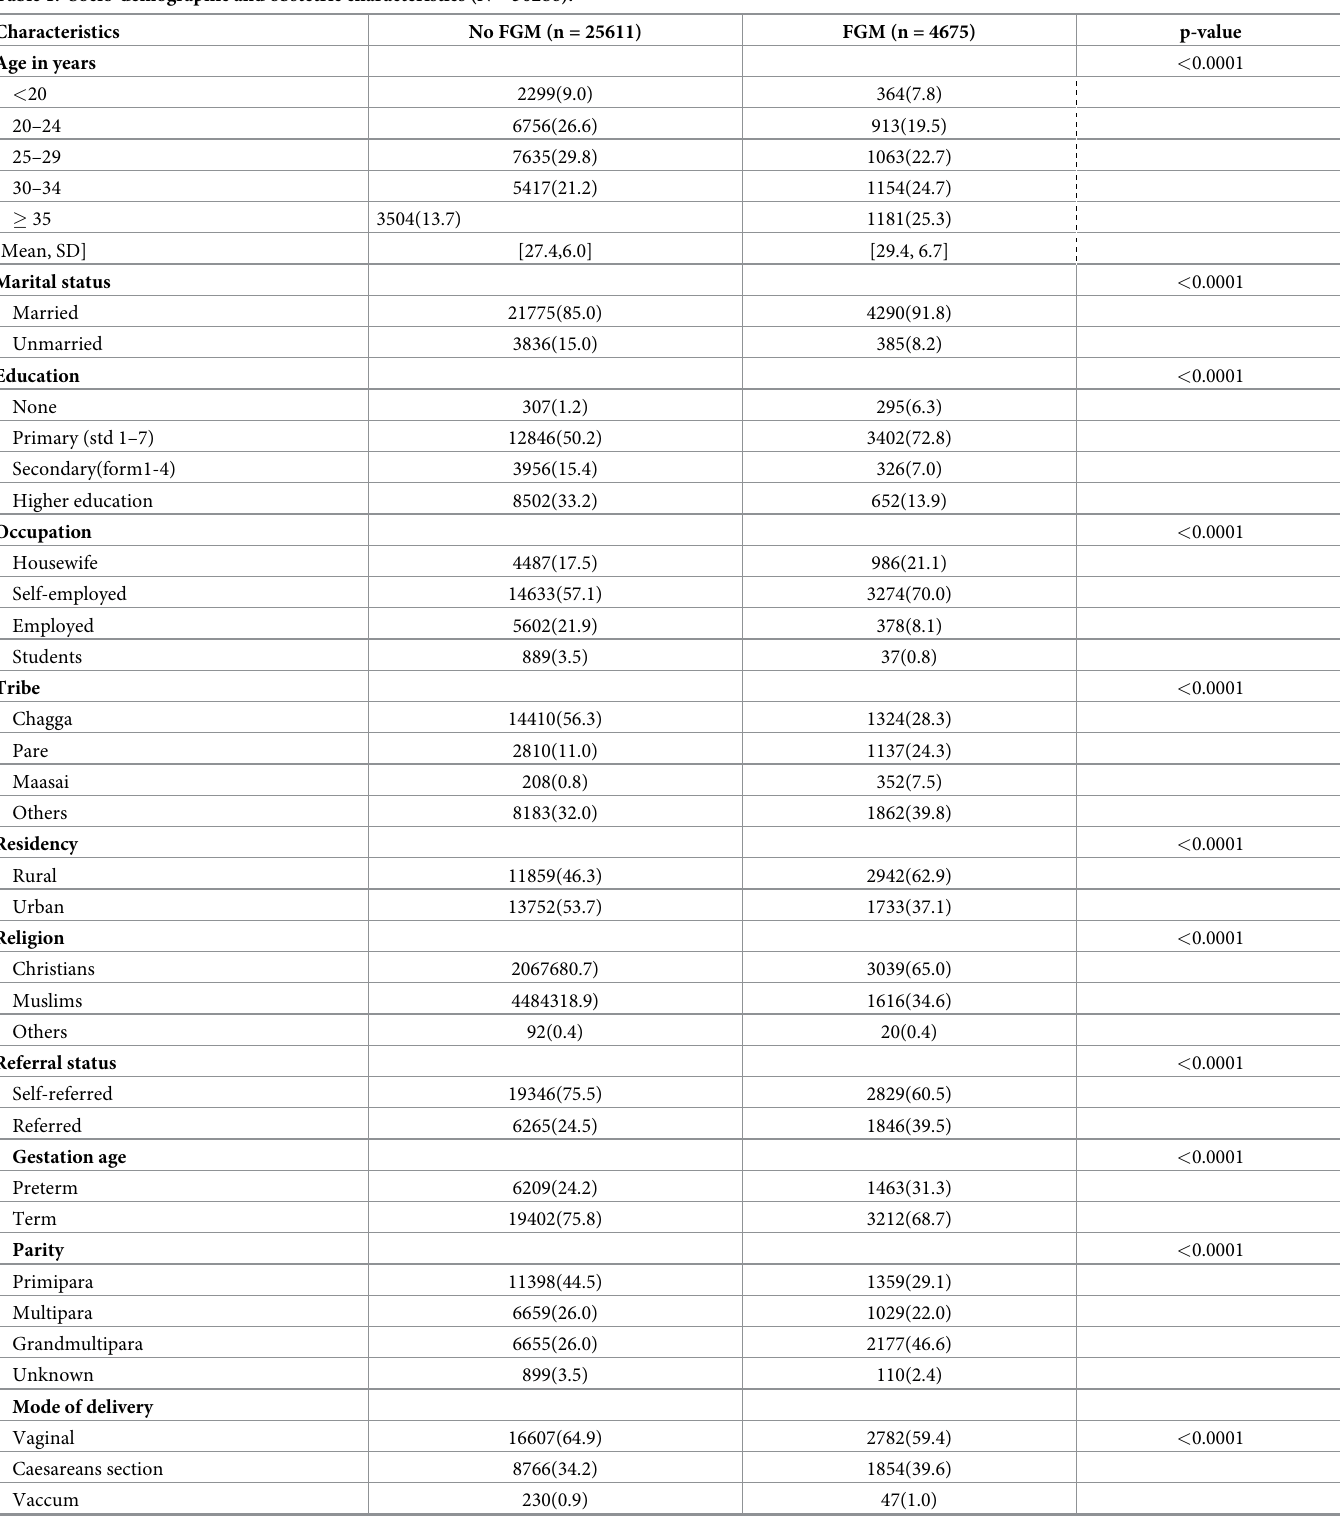
Table 1. Socio-demographic and obstetric characteristics (N =